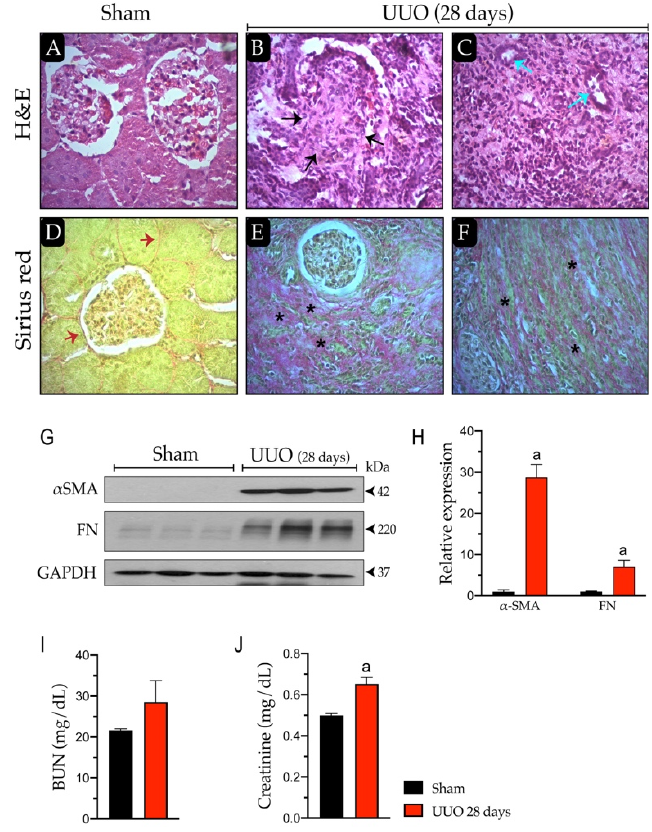
Figure 1. Characterization of the unilateral ureteral obstruction (UUO) model. Hematoxylin-eosin (H&E) staining: ( A ) sham and ( B , C ) 28-day UUO and Sirius red staining; ( D ) sham and ( E , F ) 28-day UUO analyzed by optical microscopy (scale bars: 40×). Glomerular sclerosis (black arrow); residual tubular structures (blue arrows), stroma (red arrows), and area of medulla positive Sirius red staining (black asterisks). ( G ) Immunodetection of proteins related to renal fibrosis. ( H ) Densitometric analysis of alpha-smooth muscle actin ( α SMA) and fibronectin (FN). ( I ) Blood urea nitrogen (BUN) and ( J ) creatinine levels were measured in serum samples. Data represent mean ± SEM of 3–4 independent experiments. a p ≤ 0.05 vs. sham. GAPDH: Glyceraldehyde-3-phosphate dehydrogenase.